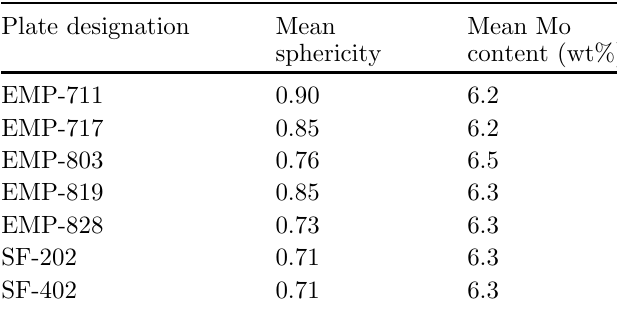
Table 2. Sphericity and Mo content of U(Mo)